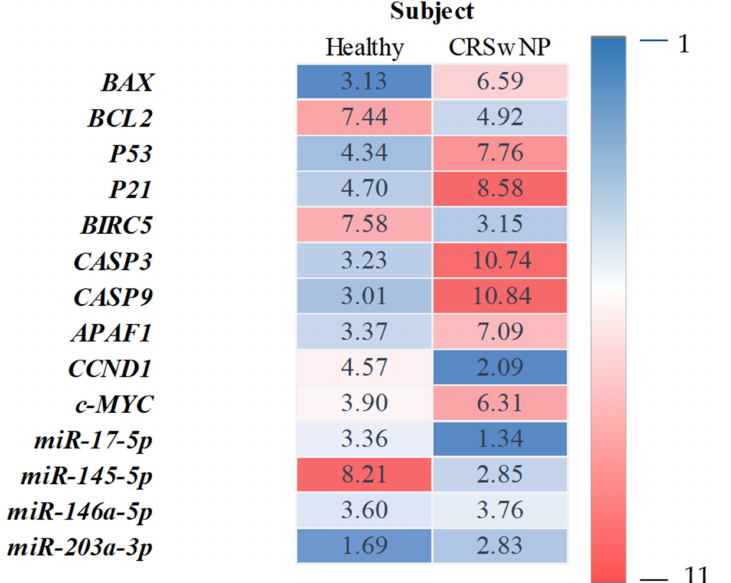
Figure 4. Summary of the obtained transcripts expression profiles. Heatmap showing the examined mRNA and miRNA levels in the healthy subjects ( n = 10) and CRSwNP patients ( n = 10). Each RT-qPCR was done with at least three technical repetitions. The heatmap shows the mean relative transcript amount obtained for healthy subjects and CRSwNP. Levels of down expression (blue) or overexpression (red) are shown on a log2 scale from the high to the low expression of each